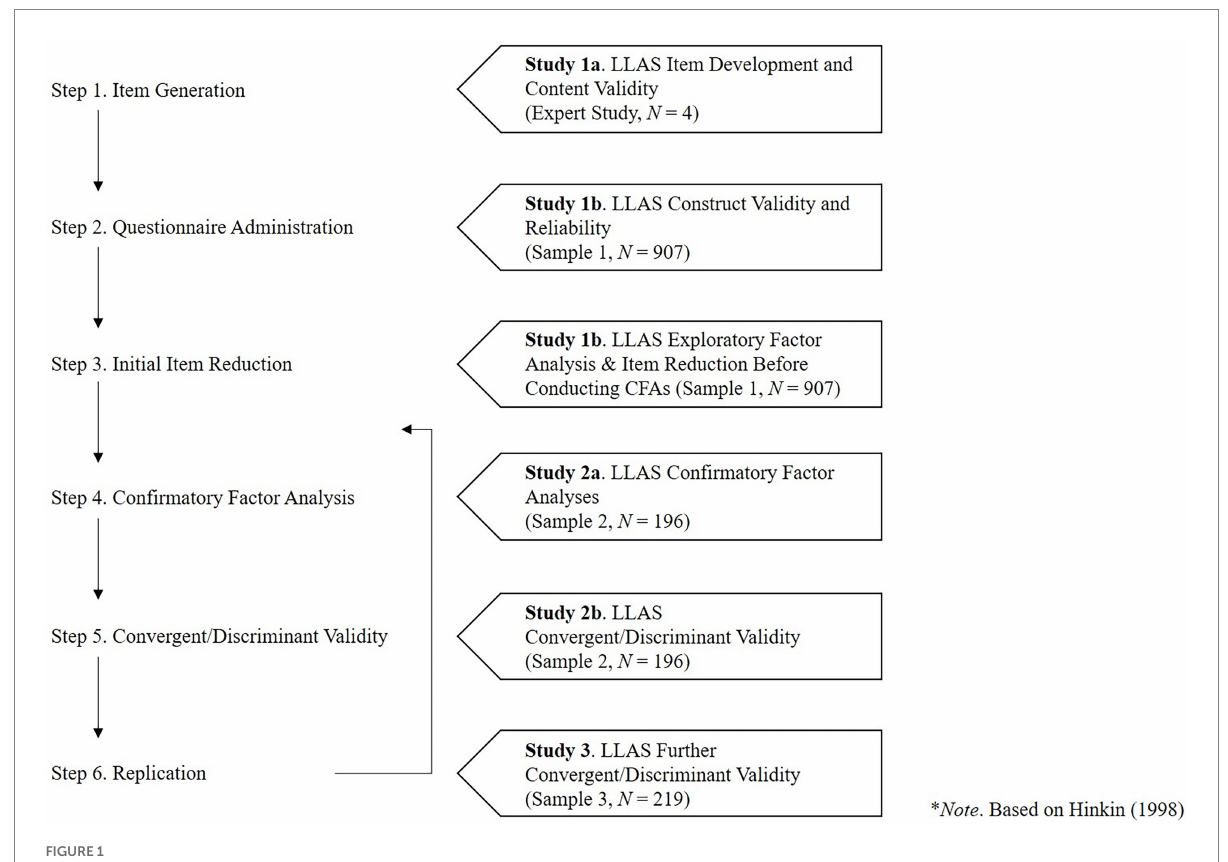
FIGURE 1 Six-step scale development approach* and overview of the different